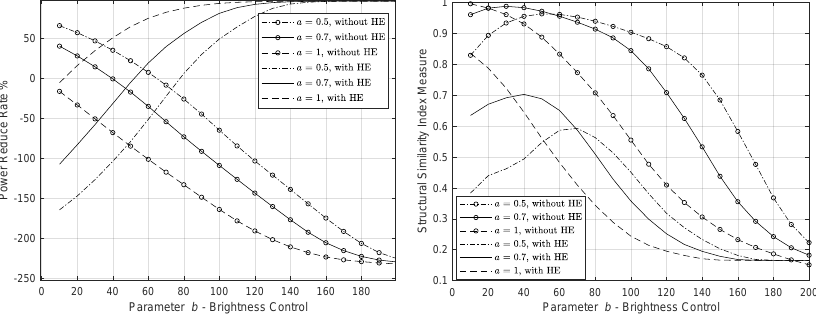
Figure 3. PRR and SSIM of the Y CBCS (without HE) and Y new ( Y CBCS with HE) for Lena